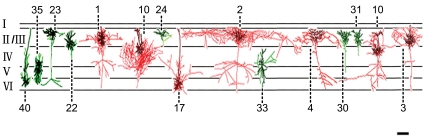
Morphological features and laminar distribution of 15 injected neurons conformed to the common cortical template.The data were collected from different animals. For better illustration, two colors (red and green) were used. For F-ERF neurons, axons are shown in bright red and dendrites are shown in dark red. For S-ERF neurons, axons are shown in bright green, and dendrites are shown in dark green. Neurons with F-ERF have widely distributed axon collaterals. Neurons with S-ERF have fewer dendrite branches, and their axon collaterals are close to the cell body. Roman numerals on the left indicate the cortical layers, and Arabic numerals denote the cell numbers which are equivalent to the cell numbers in Table 1. Scale bar: 300 µm (not adjusted for shrinkage).